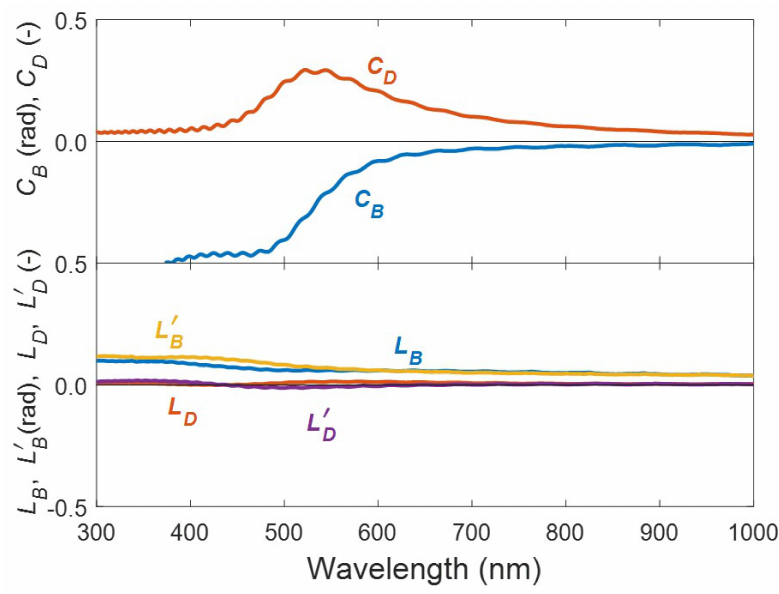
Figure 14. Birefringence and dichroism of the cellulose nanocrystal film determined by differential decomposition of the experimental data in Figure